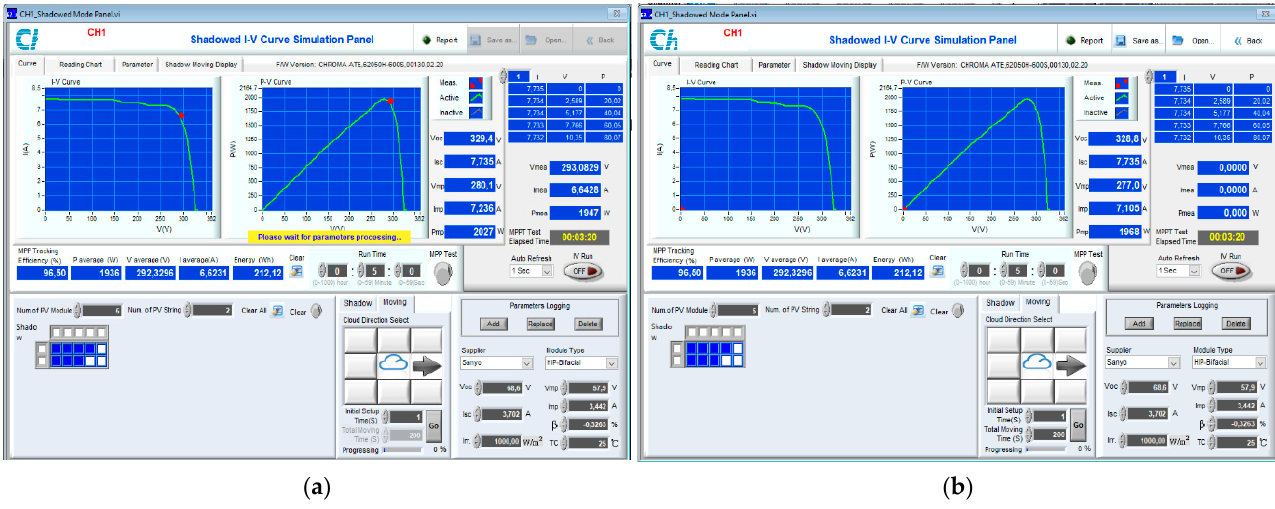
Figure 14. EKF MPPT test of two − phase IBC with 2 kW load: ( a ) partial shading and global MPPT tracking; ( b ) overall MPPT tracking efficiency.